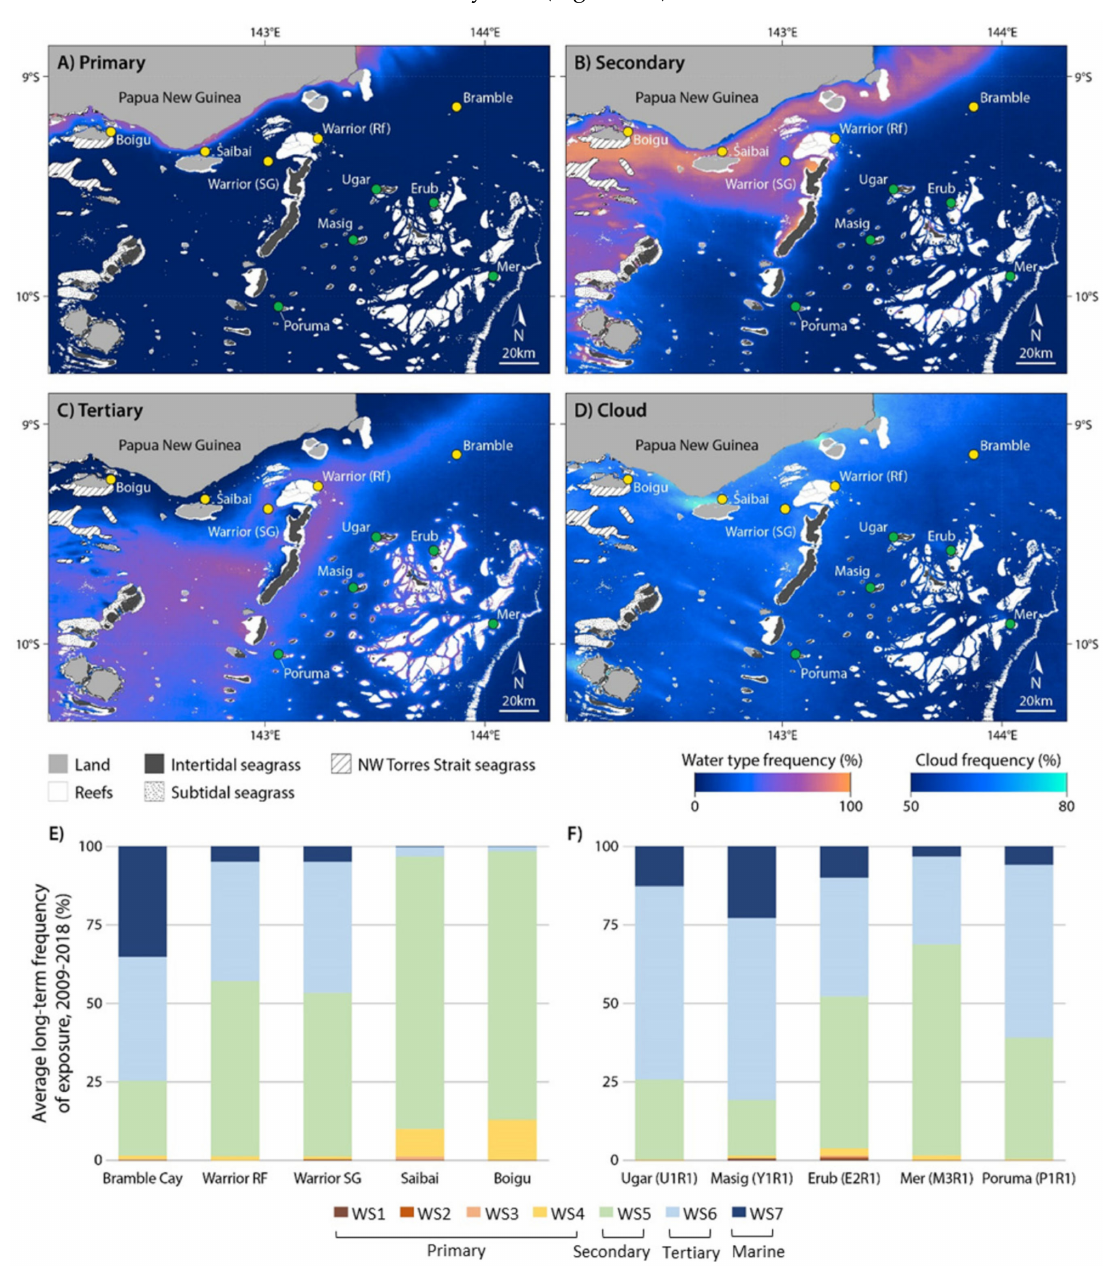
Figure 7. Maps showing the decadal (2009–2018) normalised frequency (0–100%) of ( A ) Primary water type (WS1–4), ( B ) Secondary water type (WS5) and ( C ) Tertiary water type (WS6), where the highest frequency is shown in orange, and the lowest frequency is shown in dark blue. ( D ) Cloud frequency occurrence, where the highest frequency is shown in light blue, and the lowest frequency is shown in dark blue. Bottom plots show the long-term frequency (% of exposure) extracted at a selection of key coral reef and seagrass monitoring sites in the TS: ( E ) northern sites (yellow dots) and ( F ) southern sites (green dot points) (extracted from